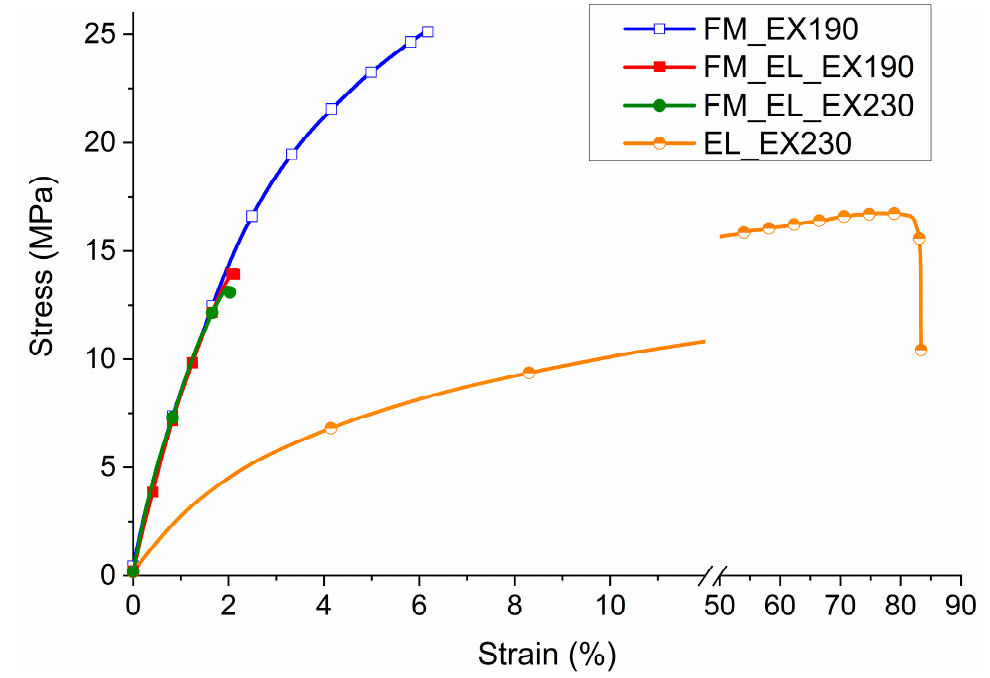
Figure 10. Stress-strain curves from tensile tests of FM_EX190, FM_EL_EX190, FM_EL_EX230, and EL_EX230.